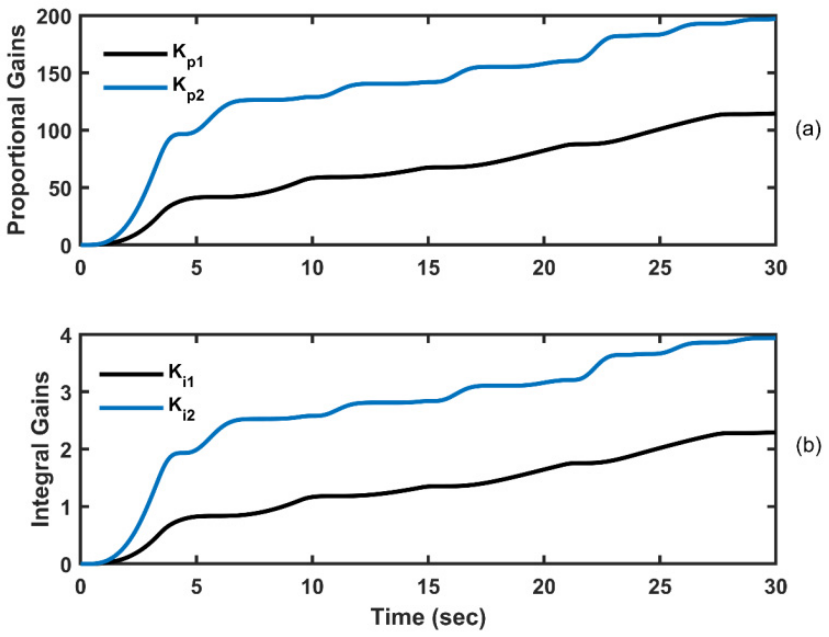
Figure 12. Adaptive controller parameters: ( a ) Proportional and ( b ) Integral Gains under wave disturbances for the two areas.